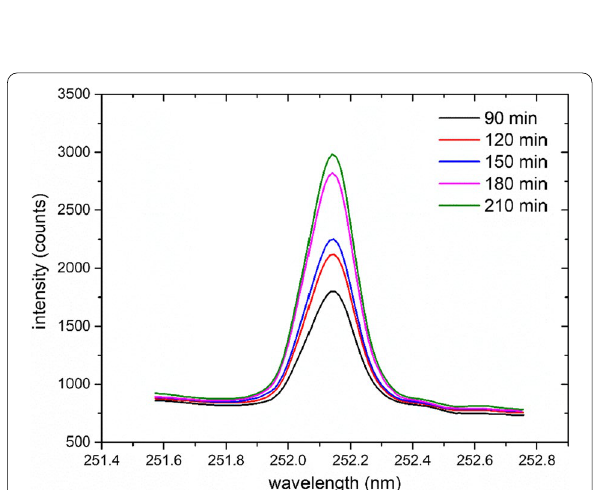
Fig. 5 ICP-OES spectrum of spiked 100 ppb Si in naphtha sample with different evaporation times